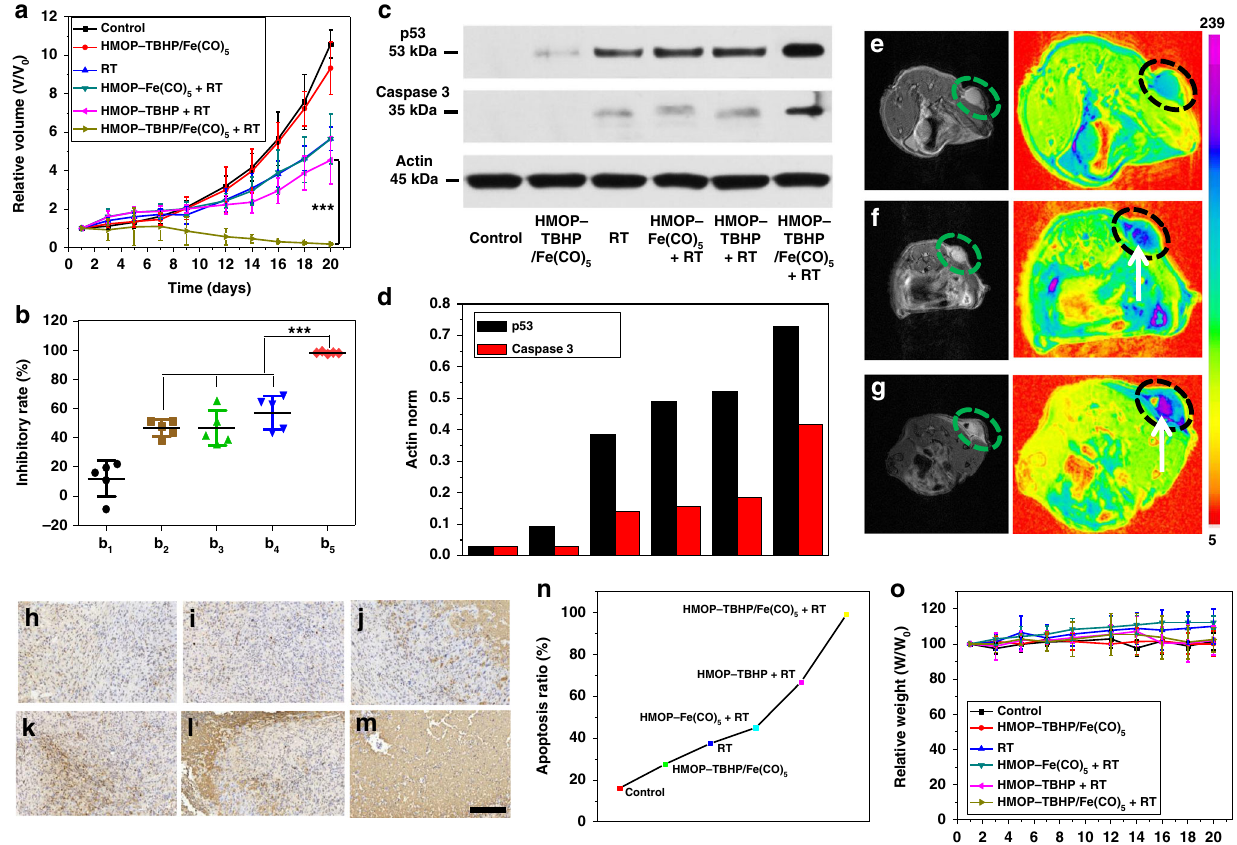
Fig. 9 In vivo evaluation of synergistic RDT/gas therapy. a U87MG tumor growth curves after different treatments. b Inhibitory rates of U87MG tumors at day 20 post treatment: HMOP-TBHP/Fe(CO) 5 (b 1 ), RT (b 2 ), HMOP-Fe(CO) 5 + RT (b 3 ), HMOP-TBHP + RT (b 4 ), HMOP-TBHP/Fe(CO) 5 + RT (b 5 ). n = 5, mean ± s.d., *** P < 0.001, Student ’ s two-tailed t -test. c Western blot analysis of p53 and caspase 3 expression in U87MG tumors after different treatments. Uncropped image available in Supplementary Fig. 44. d The corresponding quantitative analysis of p53 and caspase 3 expression in c . e – g T 2 -weighted MR imaging and the corresponding pseudo-color images of U87MG tumors at day 3 post treatment: control ( e ), RT ( f ), HMOP-TBHP/Fe(CO) 5 + RT ( g ). The white arrows refer to the apoptotic area in tumor. h – m TUNEL-stained sections of U87MG tumors subjected to different treatments: control ( h ), HMOP- TBHP/Fe(CO) 5 ( i ), RT ( j ), HMOP-Fe(CO) 5 + RT ( k ), HMOP-TBHP + RT ( l ), HMOP-TBHP/Fe(CO) 5 + RT ( m ). n = 5 sections per group. Scale bar: 200 μ m. n Quantitative analysis of tumor cell apoptosis in h – m by using the Image-pro plus 6.0 software (Media Cybernetics, Inc., MD, USA). o Weight change curves of U87MG tumor-bearing mice after different treatments. n = 5, mean ±